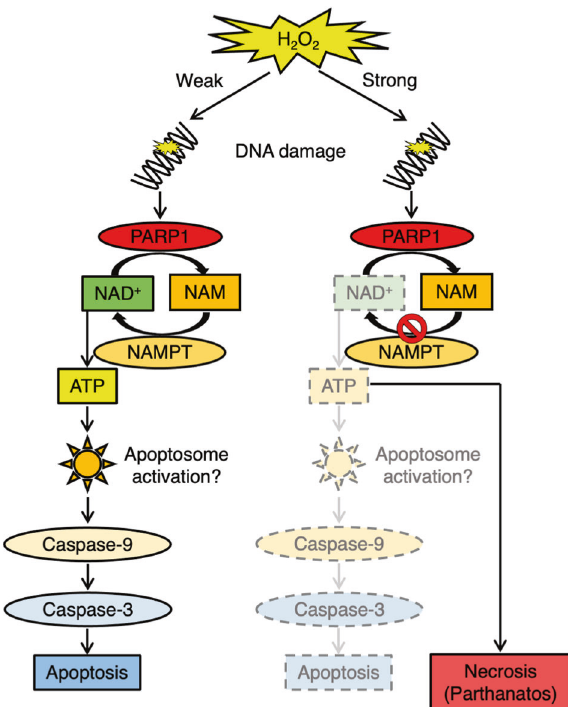
Fig. 5 Schematic model of the switch between forms of cell death under H 2 O 2 stimulation. Under weak H 2 O 2 stimulation, NAD + is consumed by PARP1 but resynthesized via the NAMPT-dependent salvage pathway. This NAD + recovery is necessary for the synthesis of ATP and induction of the intrinsic apoptotic pathway. On the other hand, NAD + resynthesis is abrogated upon strong H 2 O 2 stimulation, probably because of the impairment of the NAMPT- dependent step in the NAD + salvage pathway, resulting in the depletion of ATP, suppression of the intrinsic apoptotic pathway and induction of